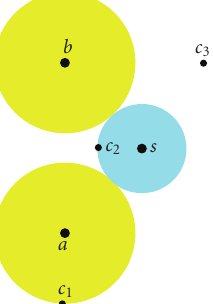
Figure 4: In this example, the atoms a and b are 5 ˚A far from each other and have both a VdW radius of 1.8 ˚A. The radius of the solvent molecule s is 1.4 ˚A. The conditions to verify for the density map before ( M ) and after ( (cid:3) M ) filtering are: M ( c 1 ) = (cid:3) M ( c 1 ) = t , (cid:3) M ( c (cid:3) M ( c M ( c = t , and M ( c 2 ) < 2 ) 3 ) < t and 3 ) < t , with t , the threshold value for the